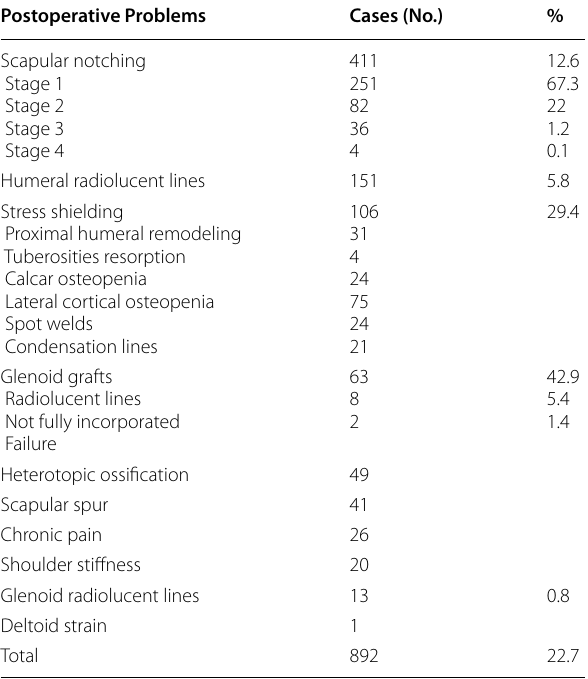
Table 4 Problems and radiographic findings